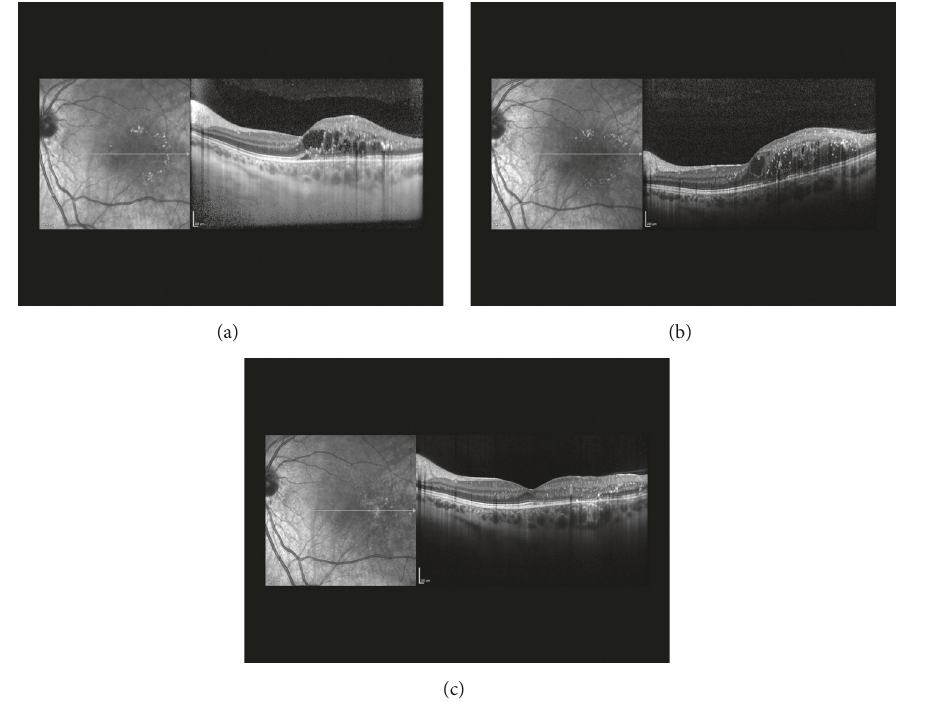
Figure 3: (a) Initial OCT of the macular with intraretinal edema and subretinal fluid. (b) Persistent macular edema despite initial peripheral laser photocoagulation and three intravitreal bevacizumab injections at 3 months. (c) Resolution of central macular edema at 12 months after repeated intravitreal aflibercept